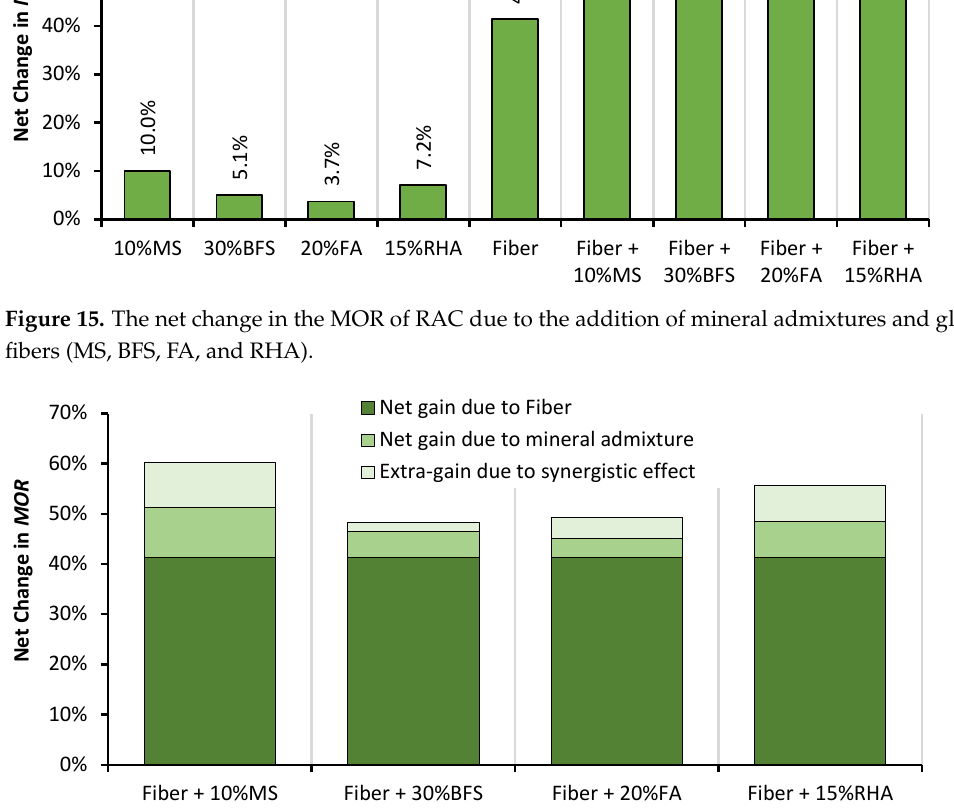
Figure 16. The net change in the MOR of RAC due to the combined effect of mineral admixtures and fibers.